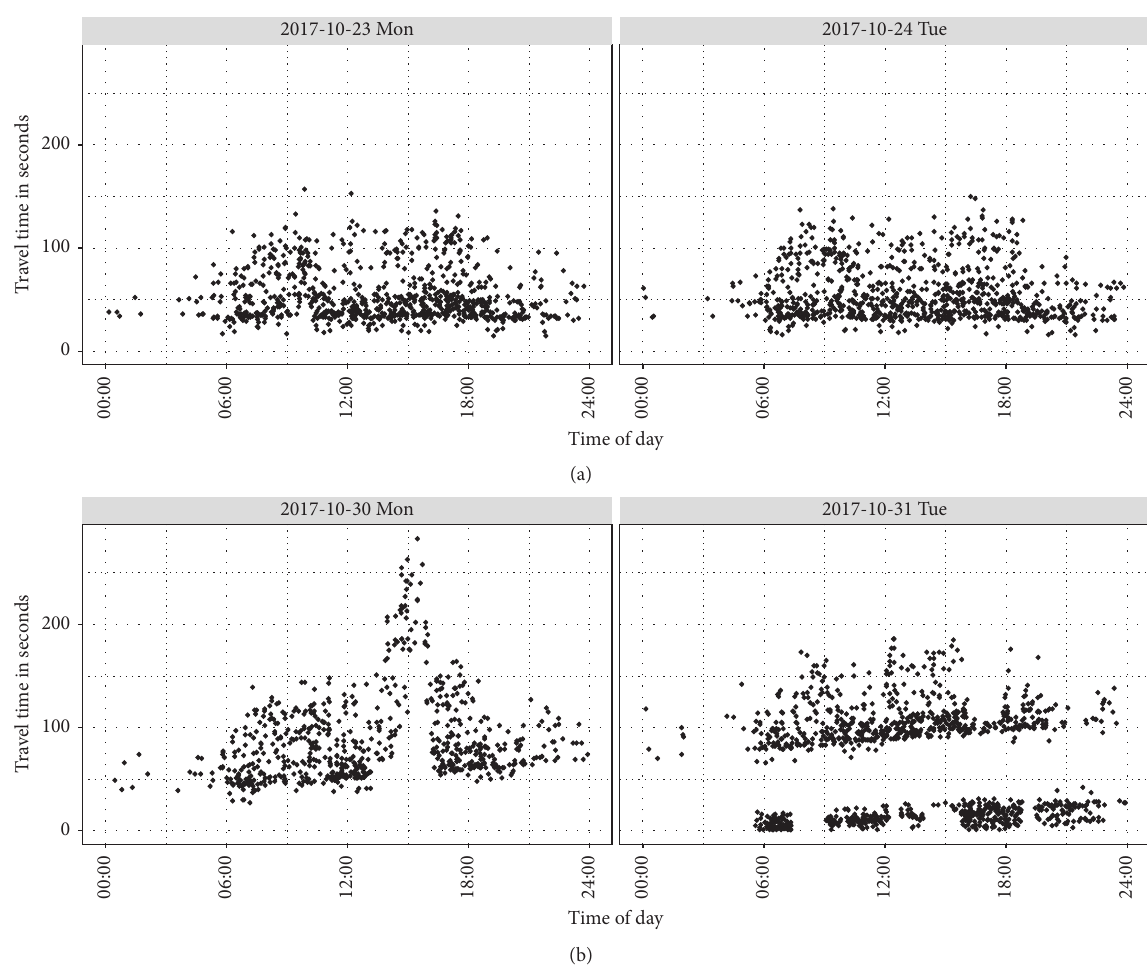
Figure 2: The clock drift phenomenon of link 998-76. (a) Although the top two subgraphs are normal, (b) the bottom two show the clock drift; in the bottom right subgraph, the TT estimates below the blank gap are from the opposite direction, link